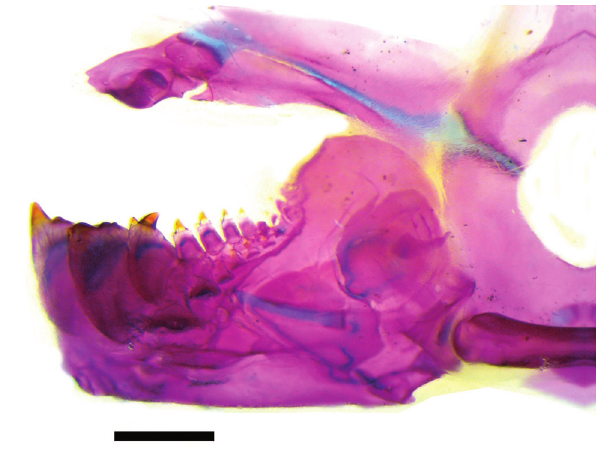
Fig. 2. Lower jaw and part of the suspensorium of Carlastyanax aurocaudatus , CI-FML 5015, 44.4 mm SL, lateral view, anterior to left. Scale bar = 1 mm.